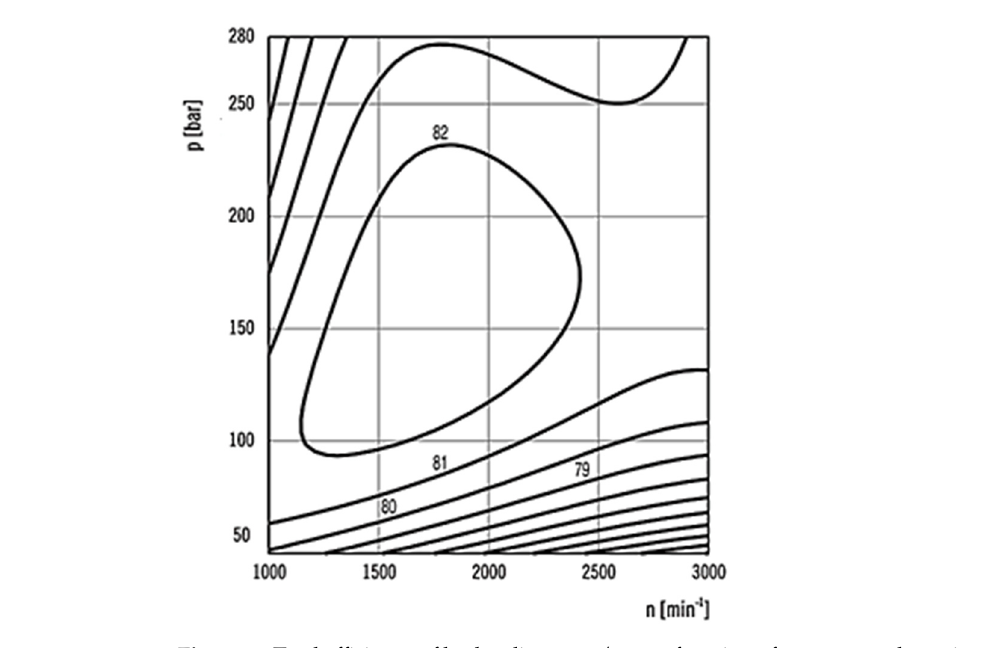
Figure 8. Total efficiency of hydraulic pump/motor function of pressure and rotational speed condition.